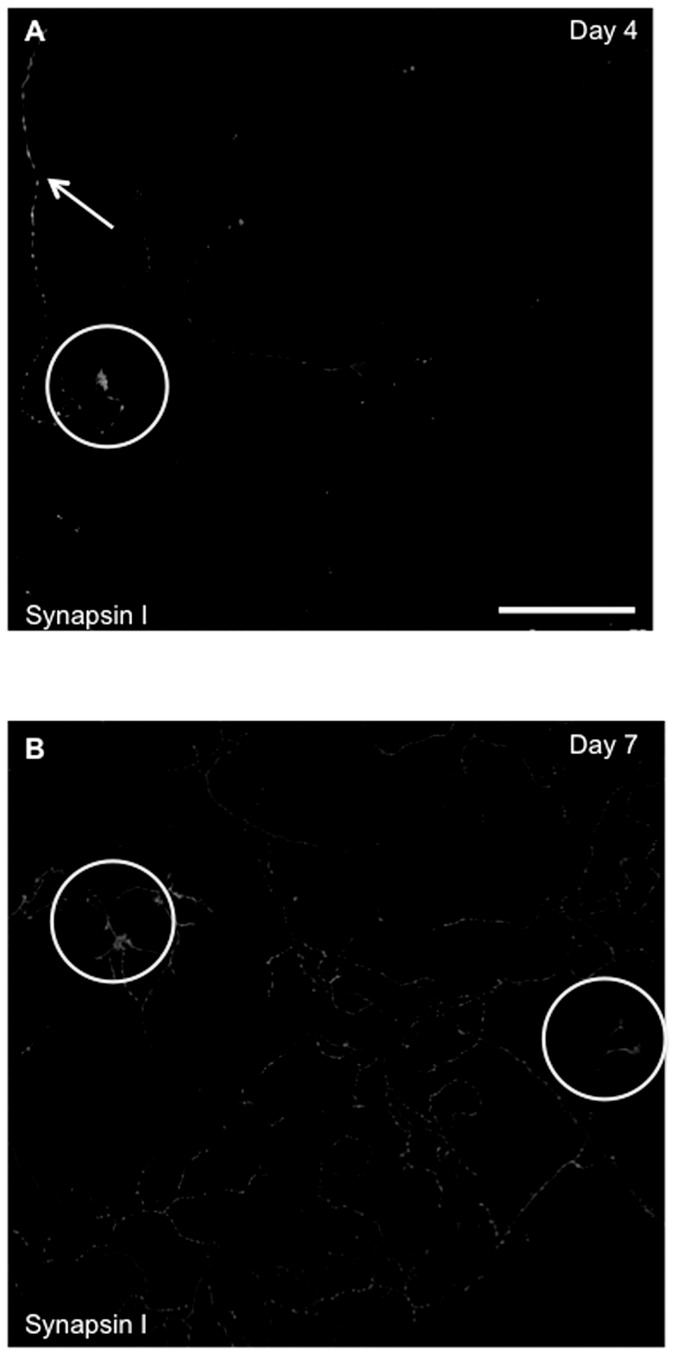
Maturity of hippocampal neurons at different days in culture.The synaptic vesicle protein Synapsin I is a marker for the maturity of the hippocampal neurons [20]. Immunolabeling with Synapsin I at day 4 (A) shows granular proteins concentrated in the distal axon and growth cone, as there is no cell-cell contact (arrow – protein in distal axon, circle- protein in growth cone), while there is a considerable increase in fluorescence intensity at day 7 (B). There is formation of large cluster of vesicles at sites of synaptic contact at day 7 (Circles-shows cell connection). The images illustrated here have been converted to grayscale and contrast enhanced, to emphasize neurites. Bar is 50 µm.